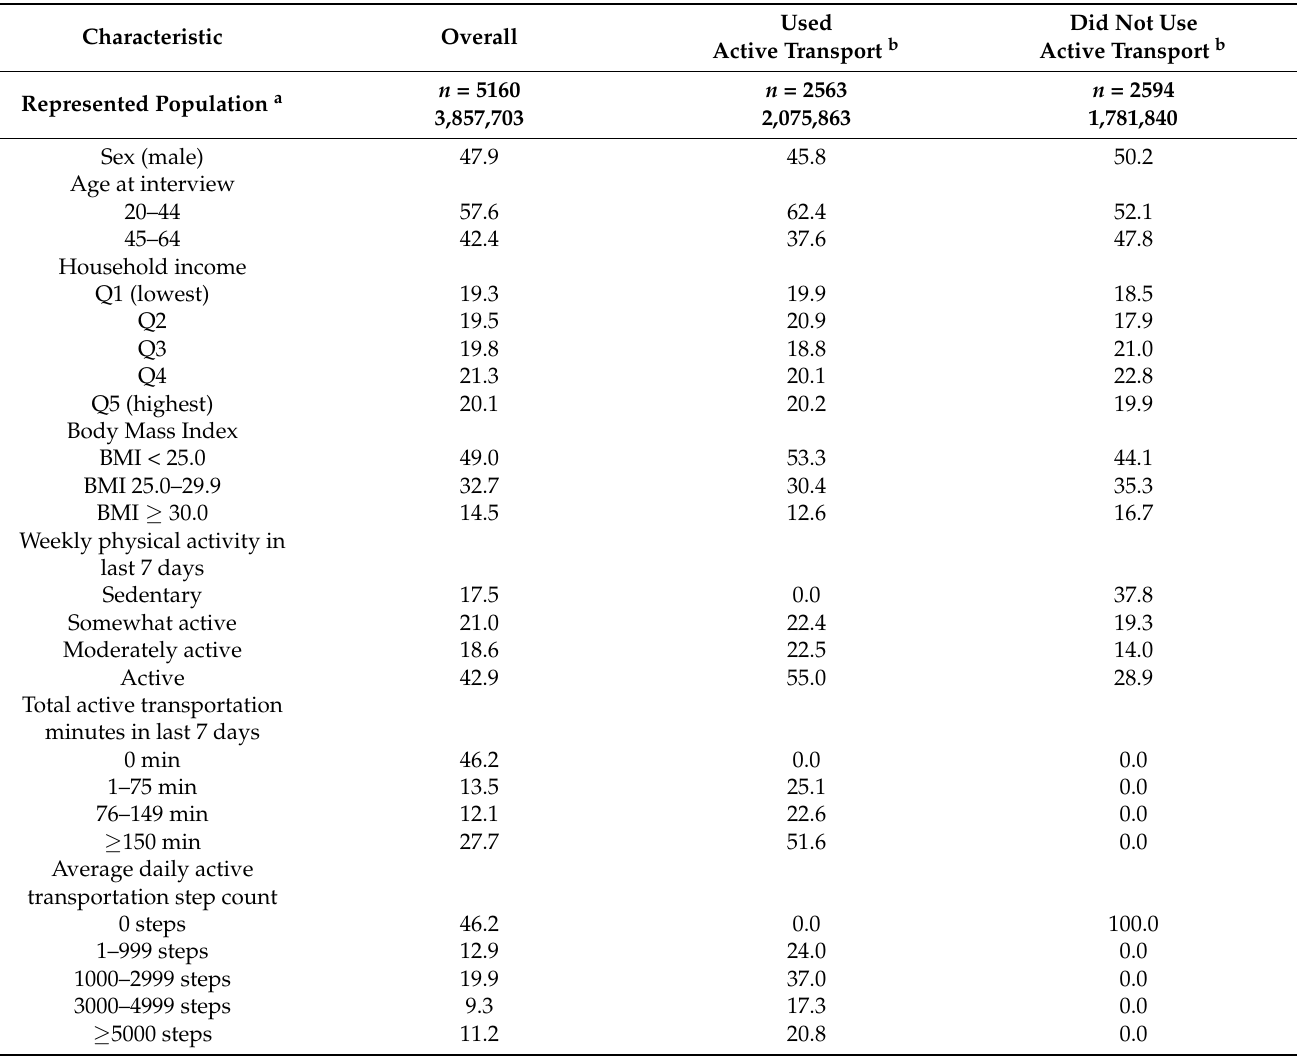
Table 2. Weighted distribution of baseline characteristics for the study